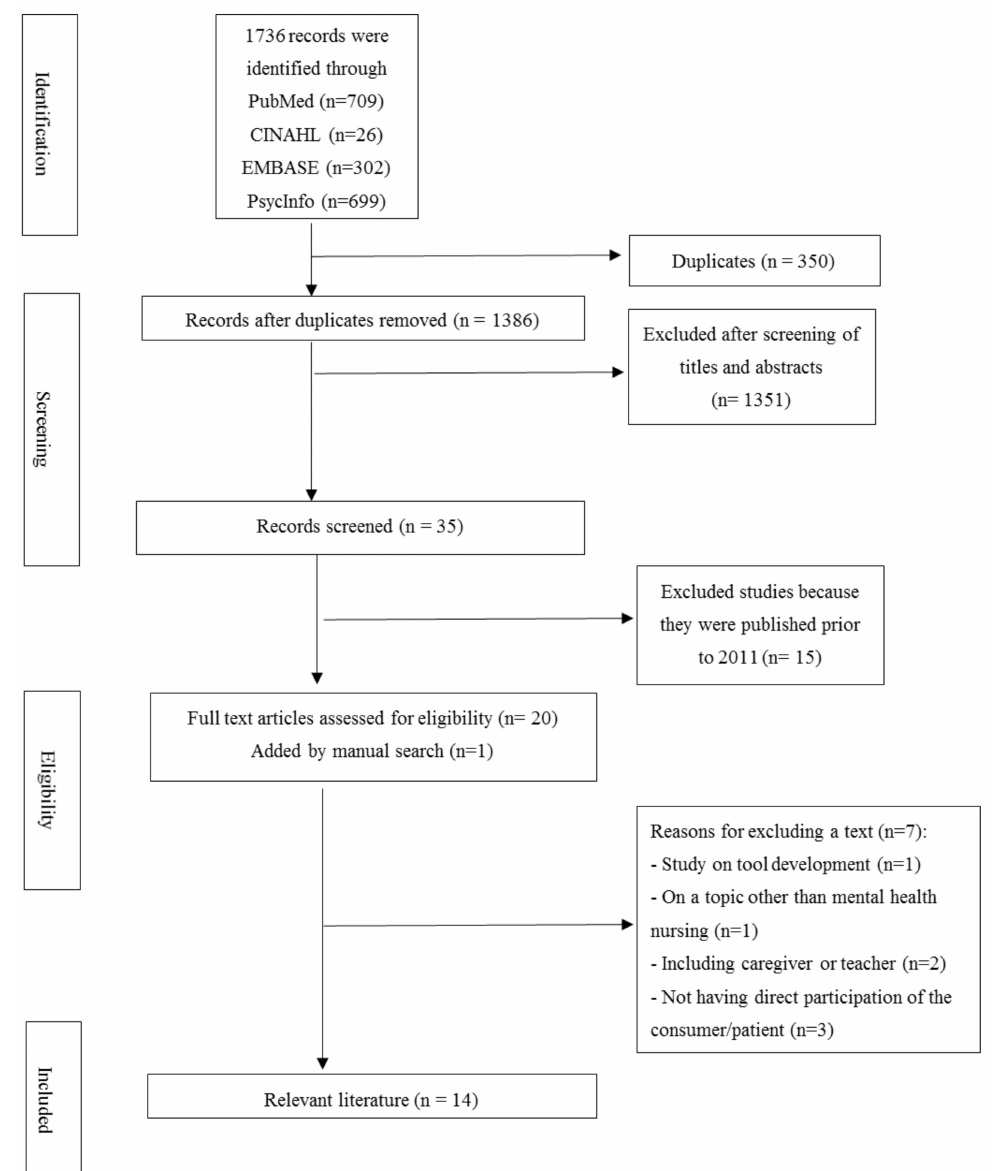
Figure 1. PRISMA flow chart of study selection. PRISMA = preferred reporting items for systematic review and